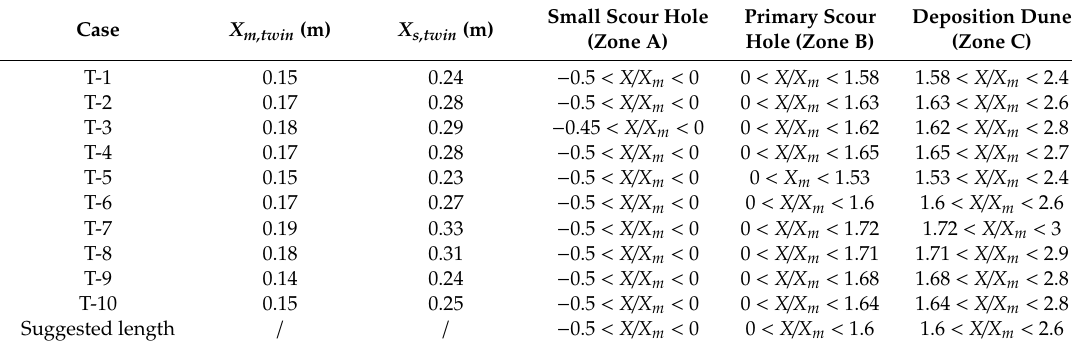
Table 5. Dimensionless length of each zone for twin ‐ propeller induced scour.